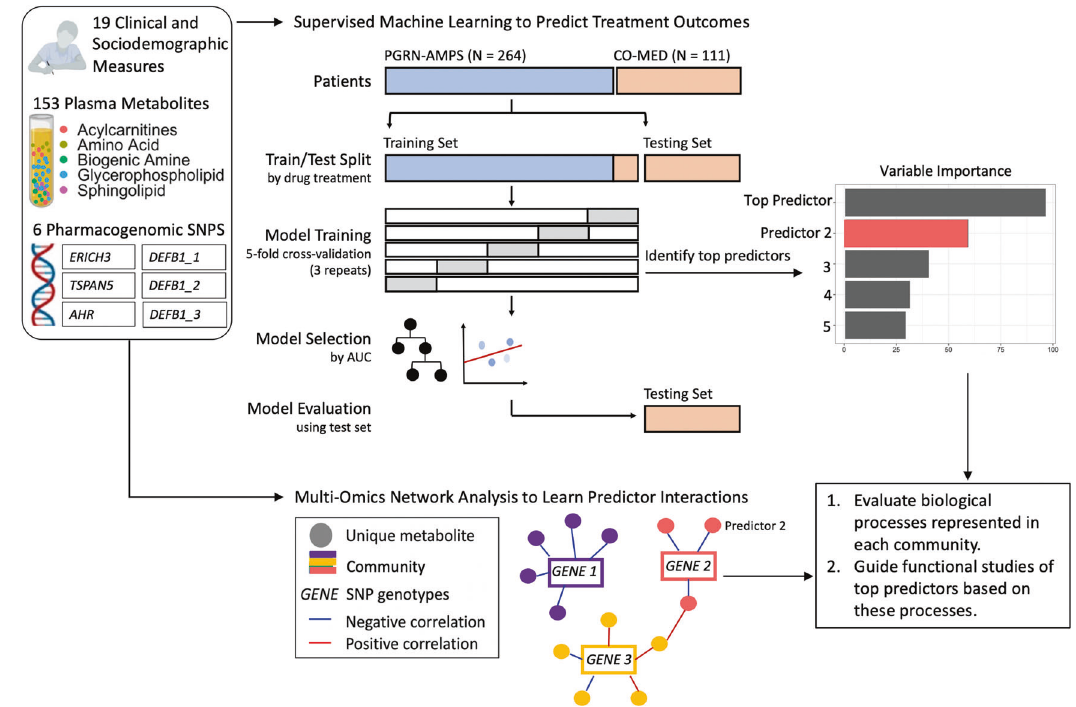
Fig. 1 Conceptual overview of model development and evaluation. PGRN-AMPS (Pharmacogenomic Research Network Antidepressant Medication Pharmacogenomic Study) and CO-MED (Combining Medications to Enhance Outcomes of Antidepressant Therapy) participants were partitioned into training/testing groups based upon treatment